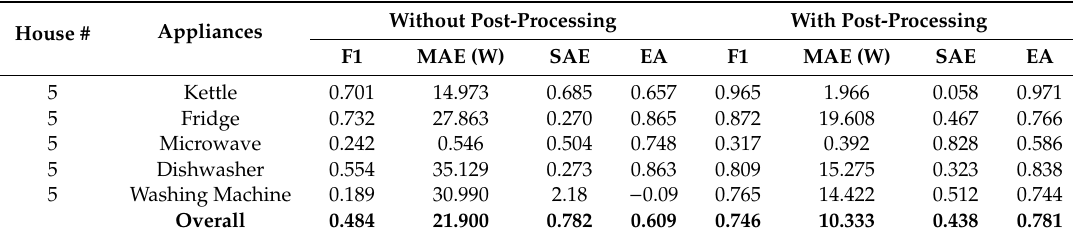
Table 4. Performance evaluation of the proposed algorithm in an unseen scenario based on the UKDALE